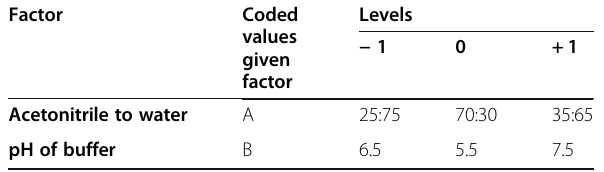
Table 1 Coded values for independent variables Factor Coded